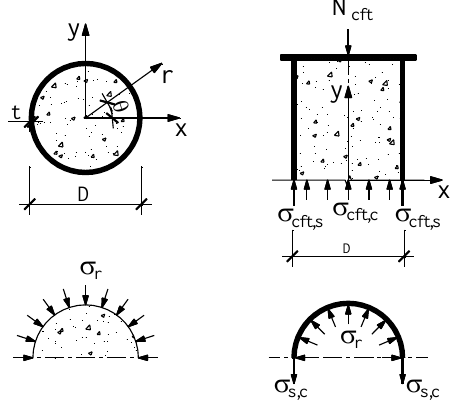
Figure 6. Different stresses in concrete filled steel tube.